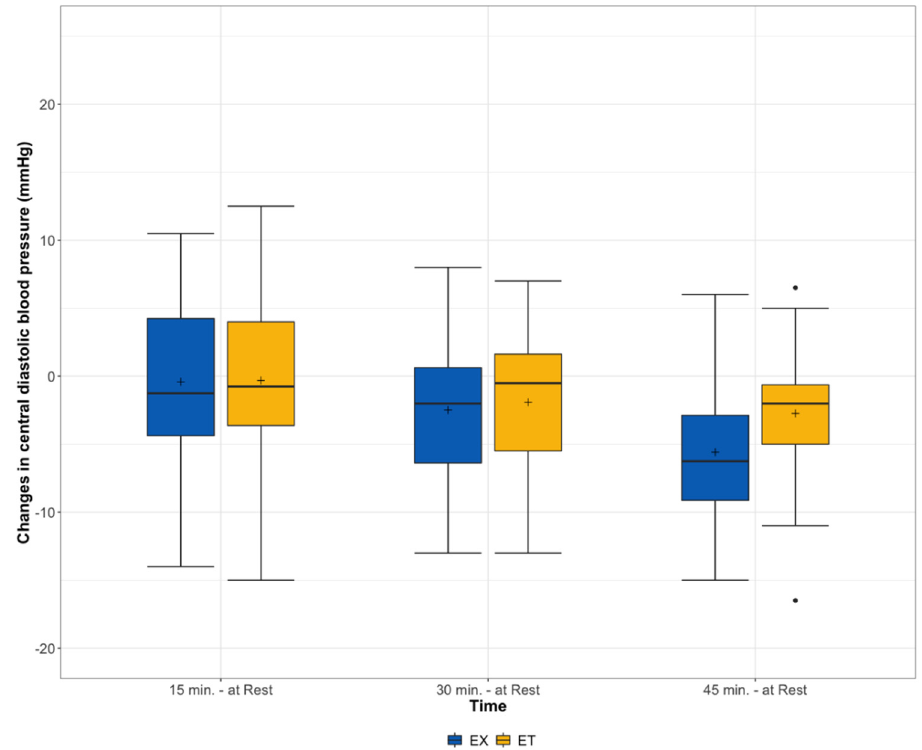
Figure 4. Changes in central diastolic blood pressure from rest before and 15, 30, and 45 min after exercise stratified according to the type of exercise (ET = moderate endurance exercise, EX = exergaming session).